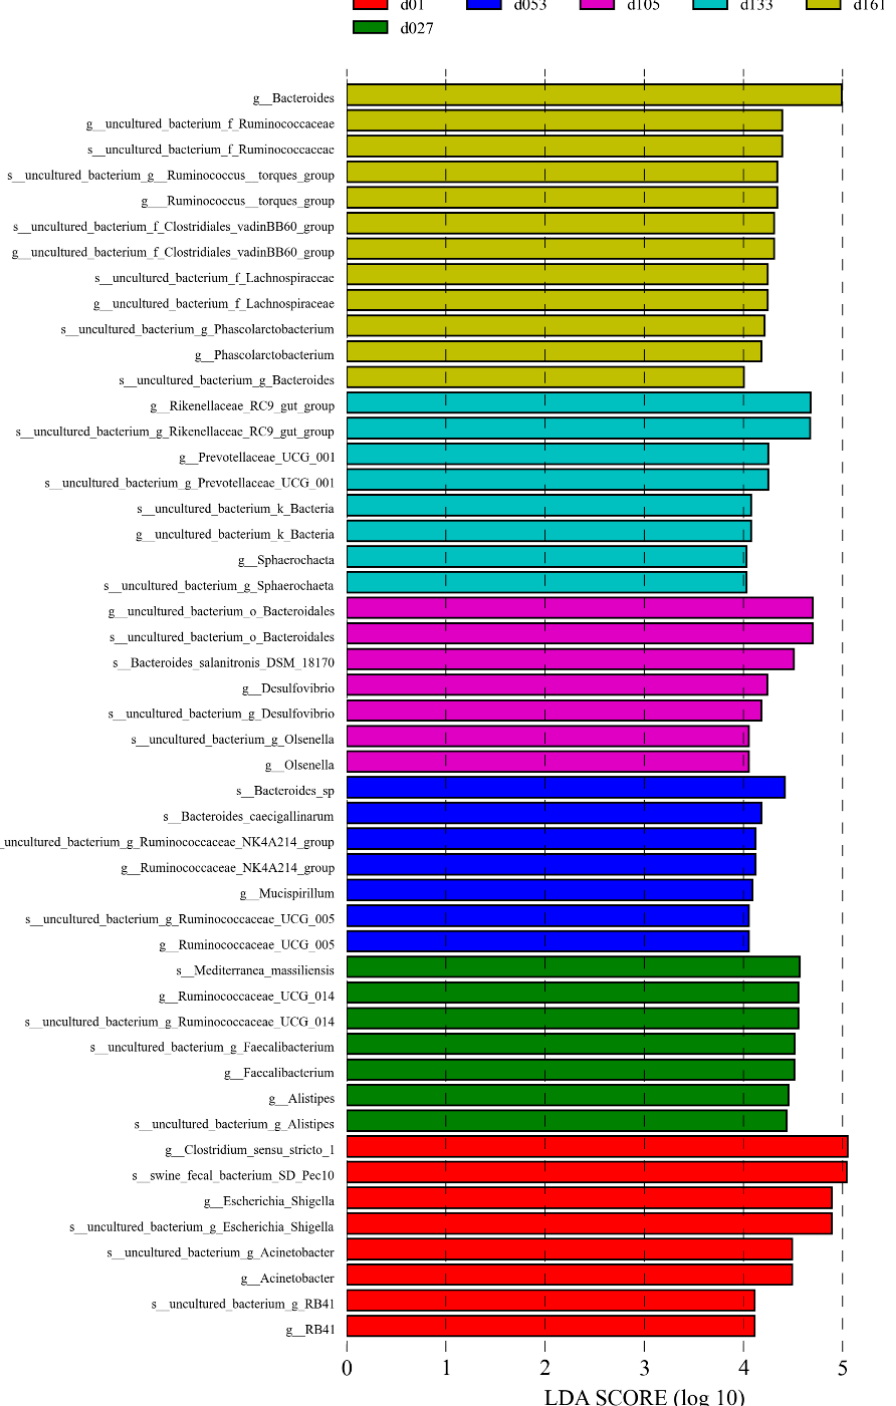
Figure 4. Cecal microbiota differences of Wenchang chickens at different development stages. A histogram of linear discriminant analysis (LDA) scores computed for differences in the proportions of cecal microbiota. Taxa meeting an LDA significant threshold of > 4 are shown. d01, n = 12; d027, n = 11; d053, n = 12; d0105, n = 12; d133, n = 12; d161, n = 12.